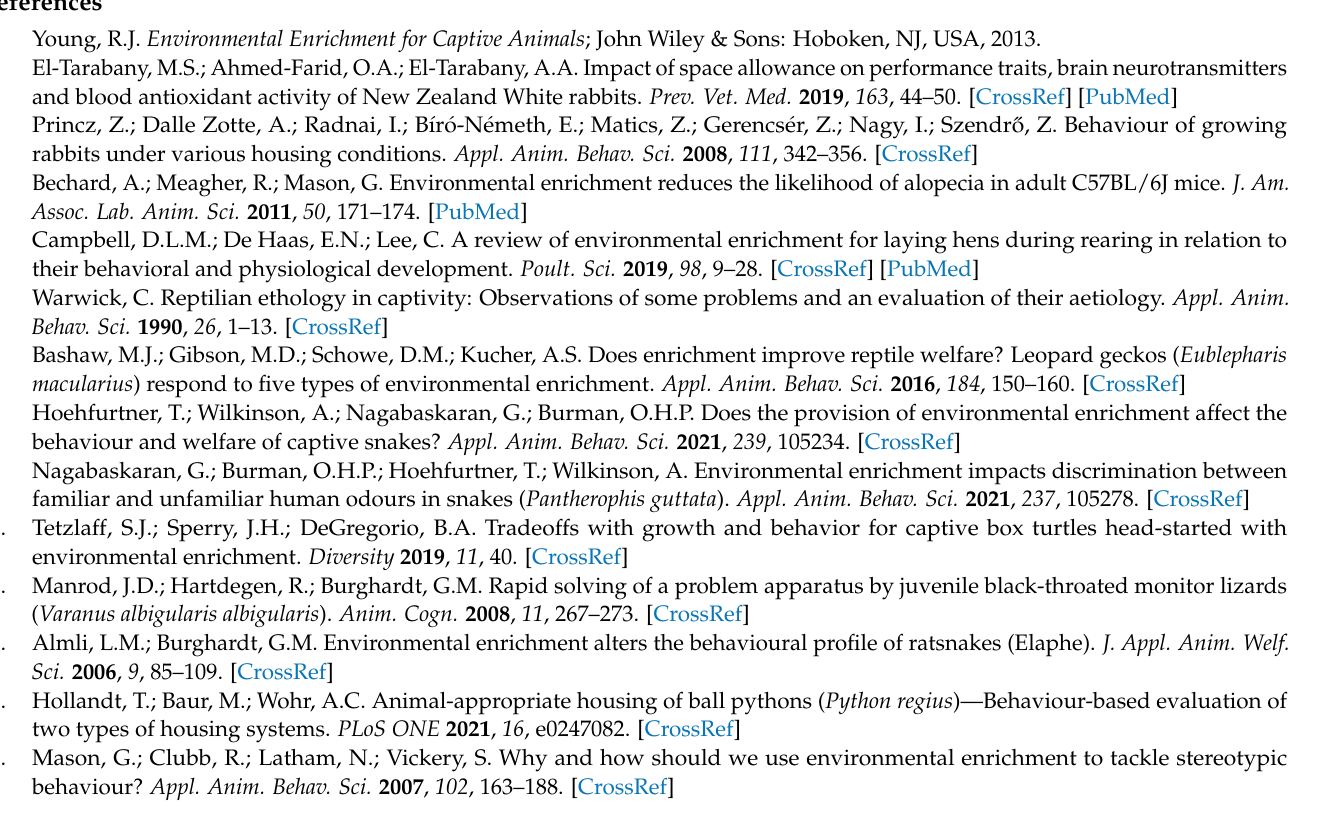
Table S1: Bayesian repeated measures ANOVA results